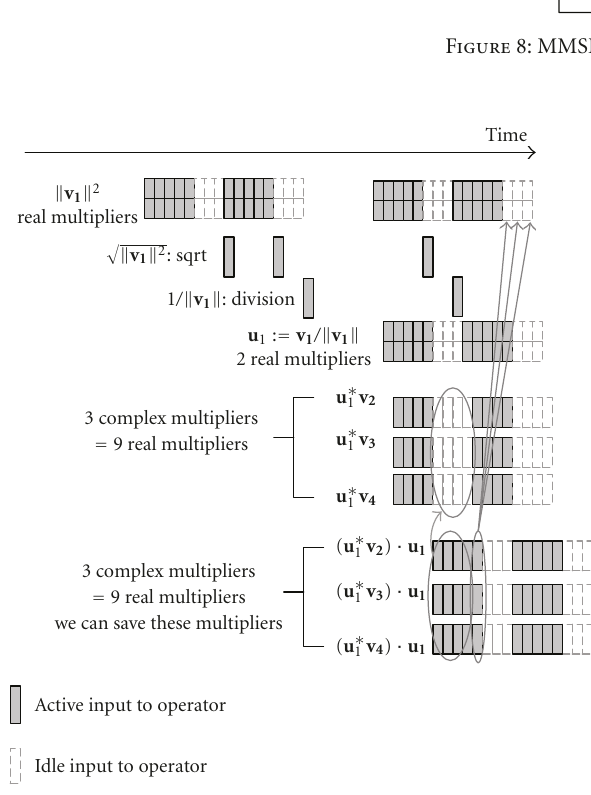
Figure 9: Vector orthogonalization schedule ( ν 1